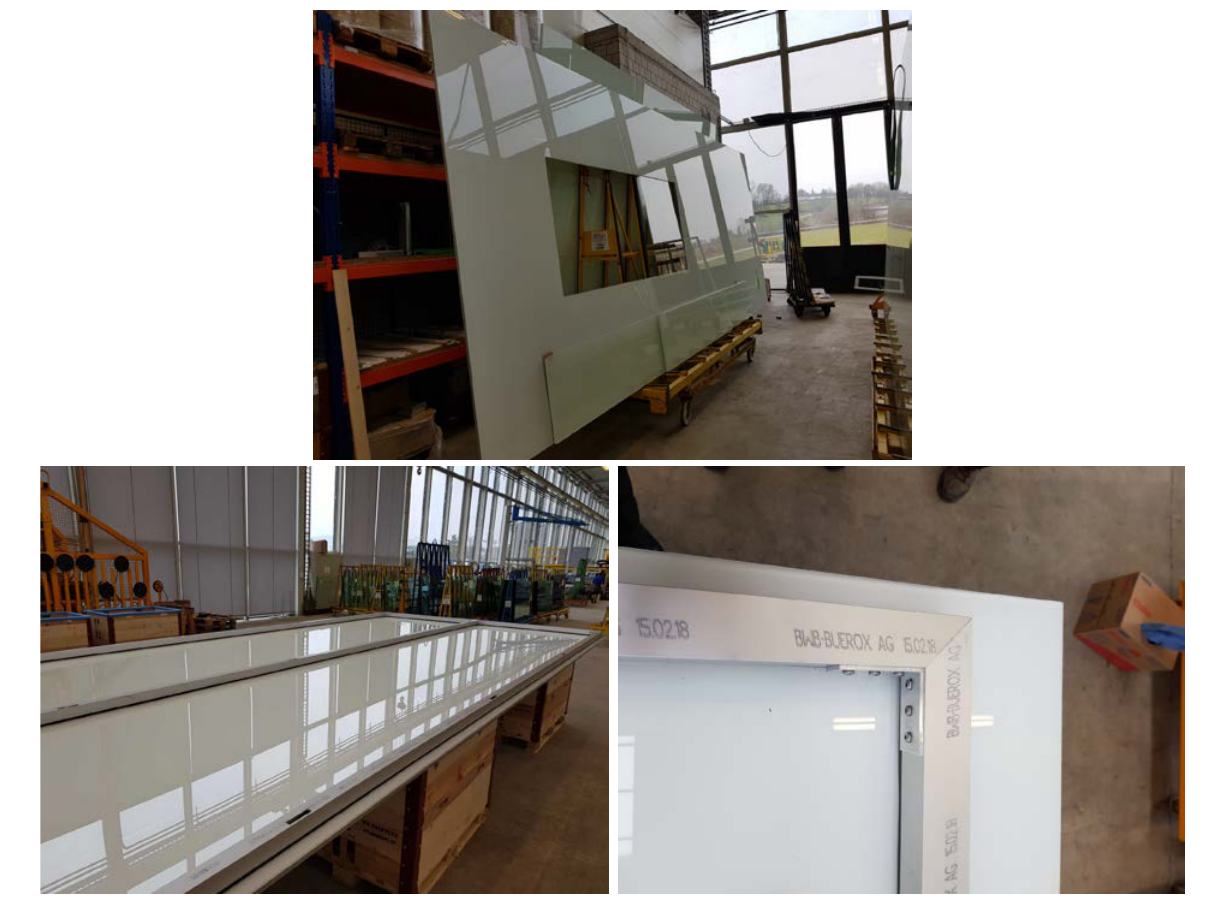
Fig. 13: Glass production and structural bonding